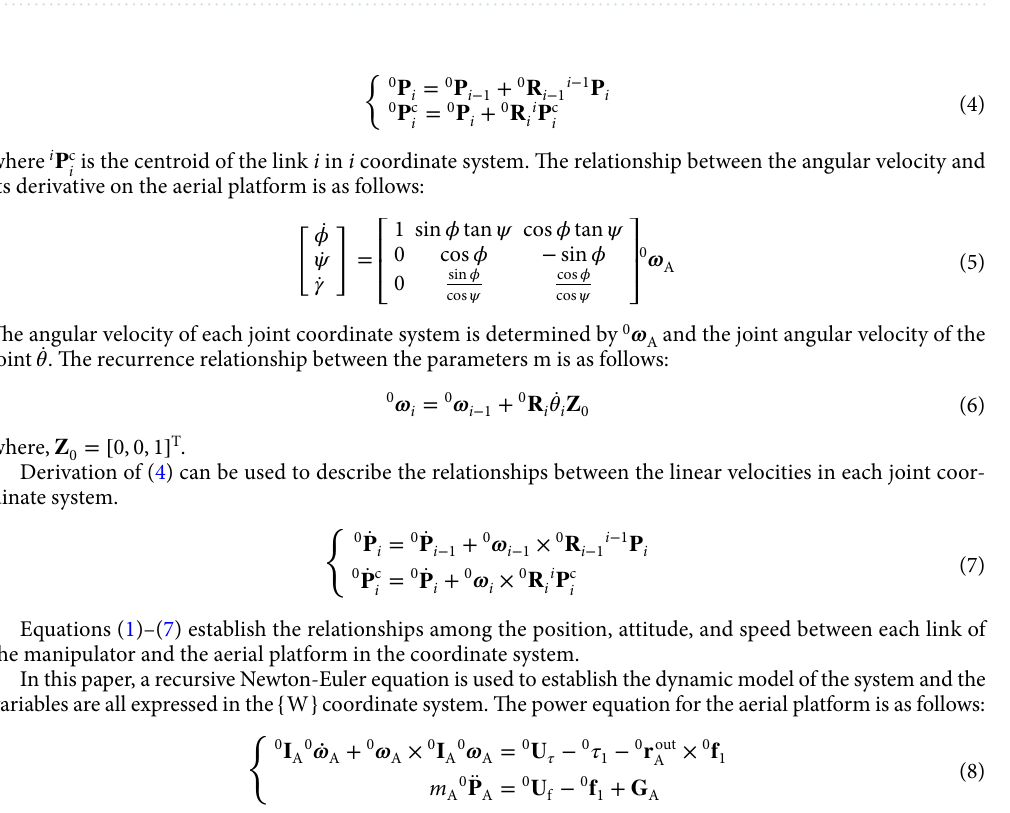
Table 1. Craig parameters for aerial